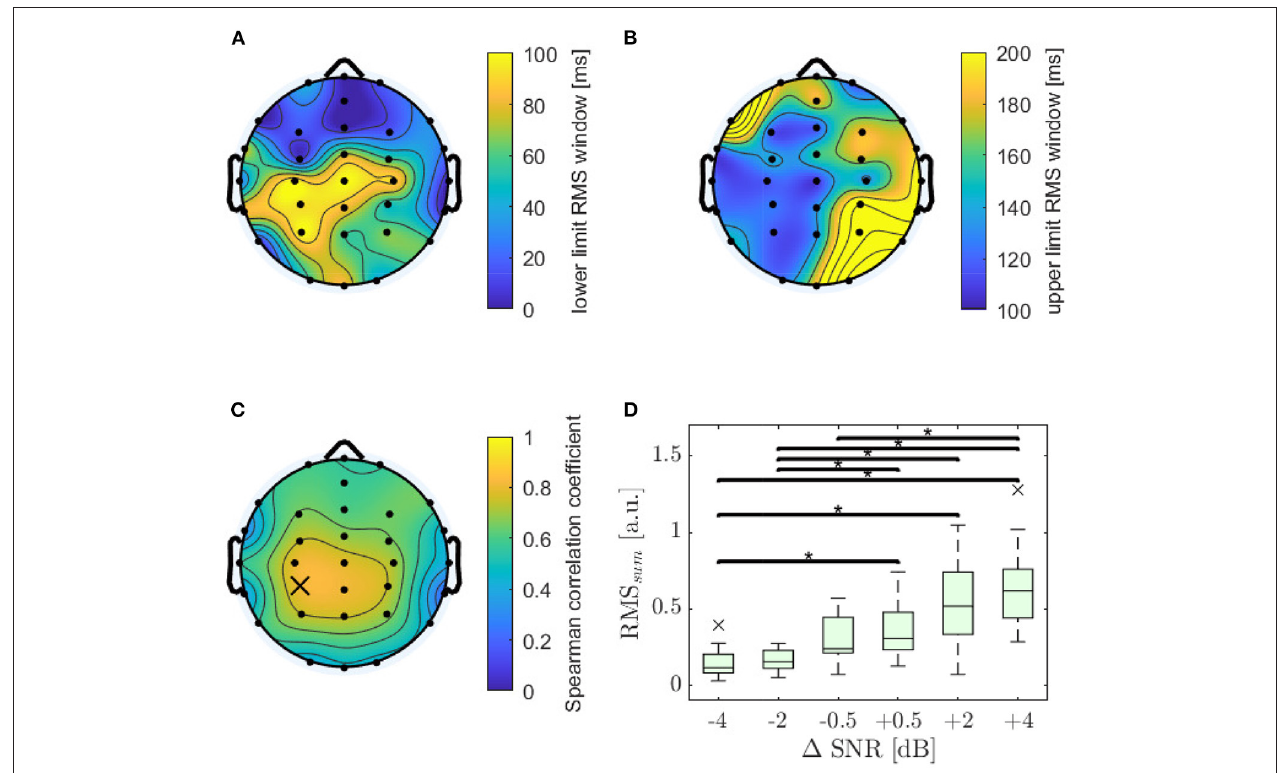
FIGURE 5 | Analysis of wave RMS-power. (A) Optimal lower limits of the time window. (B) Optimal upper limits of the time window. (C) Distribution of monotonicity for windowed RMS-power, with an optimized window for each channel, evaluated using Spearman’s ρ , which reached its maximum value at electrode CP3 (marked with a cross; ρ = 0.81; p < 0.001). (D) RMS sum values as sum of RMS values for electrode C3, CP3, and CPz for six 1 SNR and 18 subjects. Asterisks show significant differences evaluated by a Dunn-Bonferroni post-hoc test, all with a strong